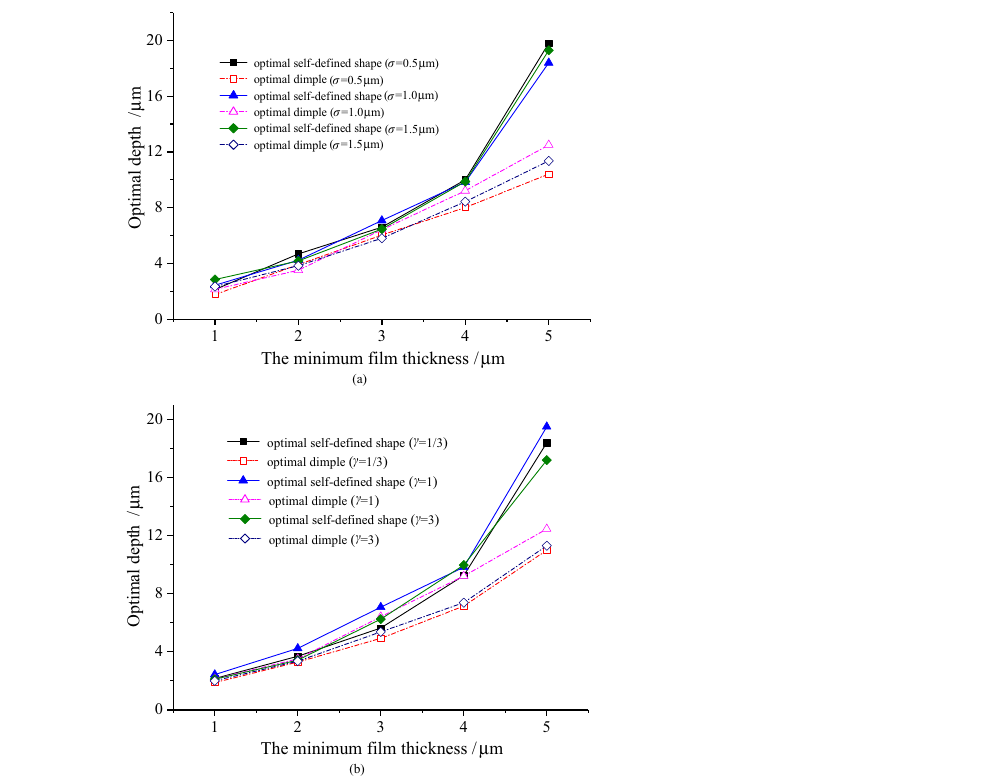
Figure 14. Variation of the optimal depth with the minimum film